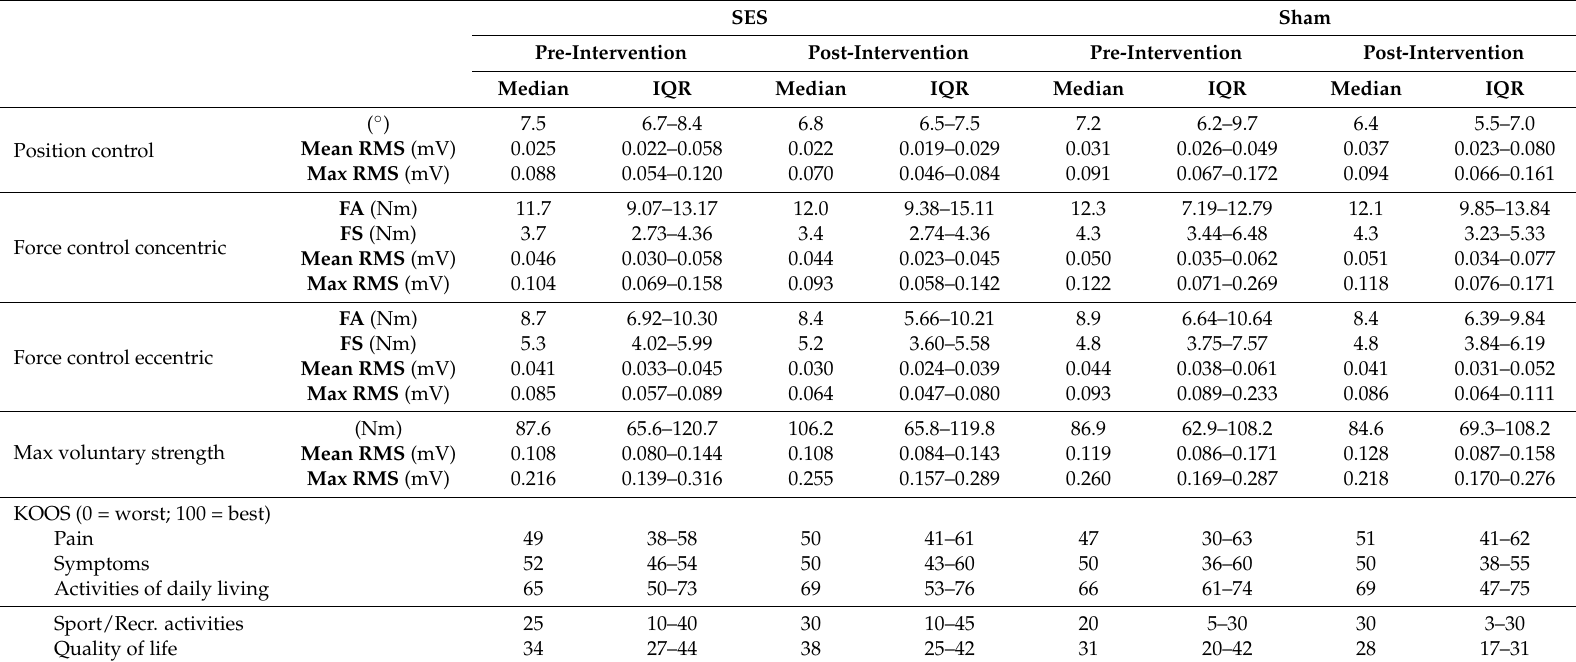
Table 1. Motor coordination, maximal voluntary strength, and electromyographic data with self-reported knee function (KOOS